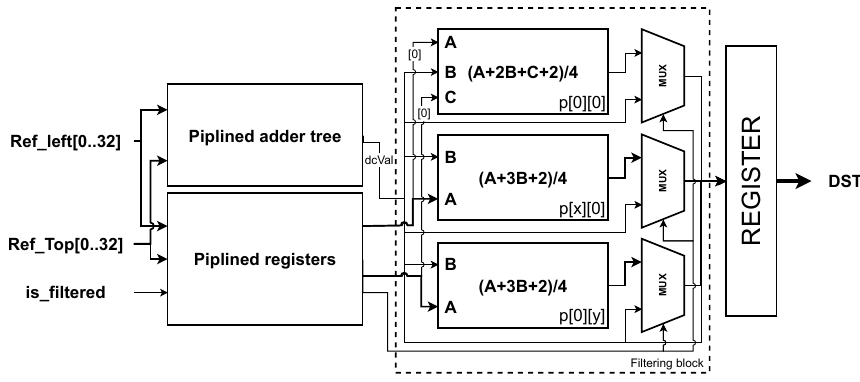
Figure 16. Hardware architecture of DC